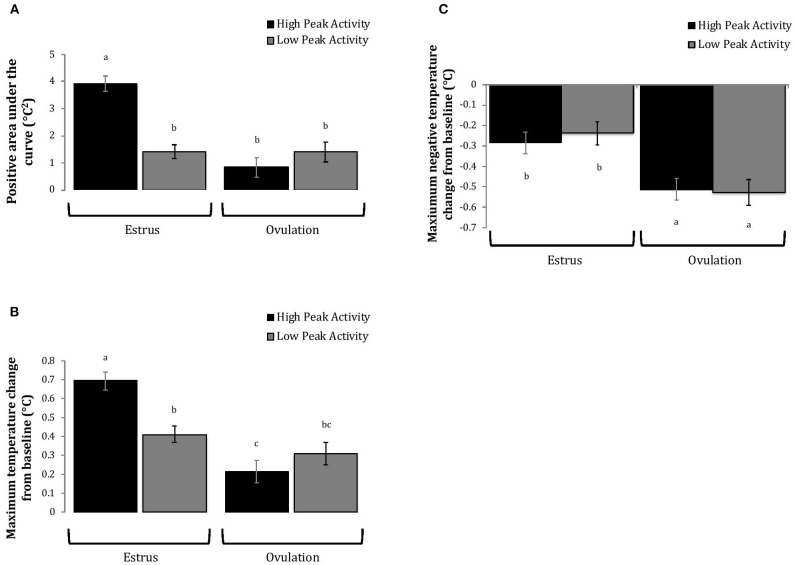
Changes in rumen-reticular temperature relative to baseline (least squared means + SE) during estrus and near ovulation in Holstein dairy cows expressing a high or low intensity of estrous expression, obtained from a mixed linear regression model as described in Table 1. The following three temperature changes are depicted: positive area under the curve [(A); P < 0.001], maximum change [(B); P < 0.01], and maximum negative change [(C); P = 0.73). Superscripts of letters a-c denote significant differences (P < 0.05) between all groups of each panel. High peak activity: estrous expression greater than the median of 80 index on the AAM. Low peak activity: estrous expression less than the median.